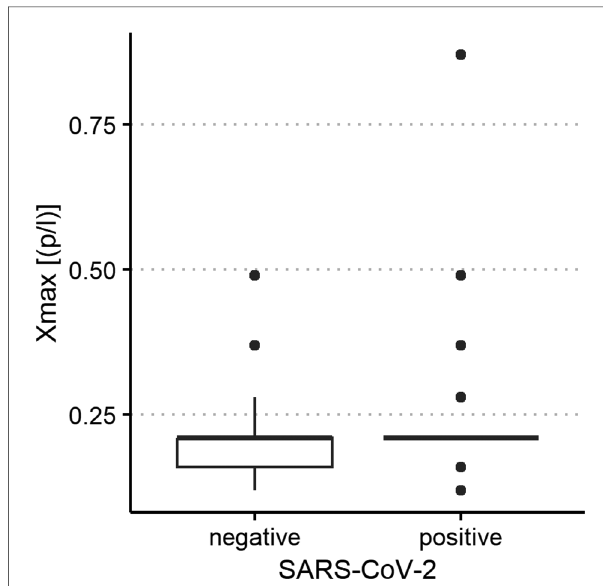
FIGURE 7 Aerosol particle size distribution of severe acute respiratory syndrome coronavirus 2 (SARS-CoV-2) polymerase chain reaction (PCR)-positive and PCR-negative children and adolescents. Maximum size of exhaled aerosol particles (in µm, displayed on the y -axis) in SARS-CoV-2 PCR- positive and PCR-negative children and adolescents ( x